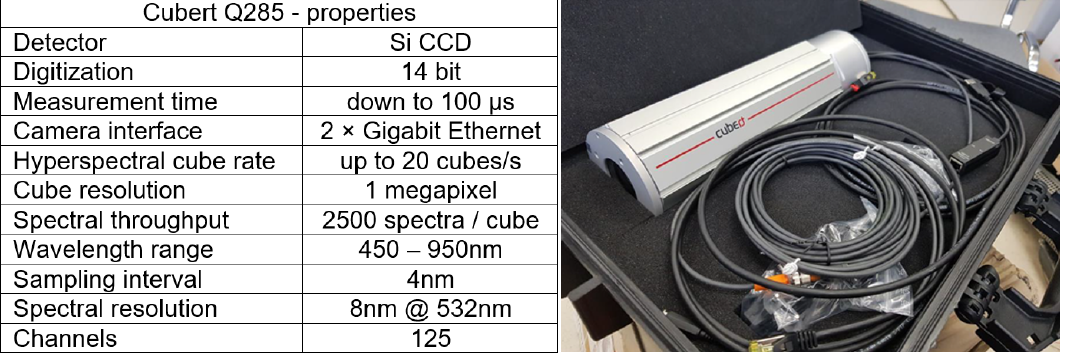
Figure 4. The image and table with properties of the hyperspectral camera Cubert